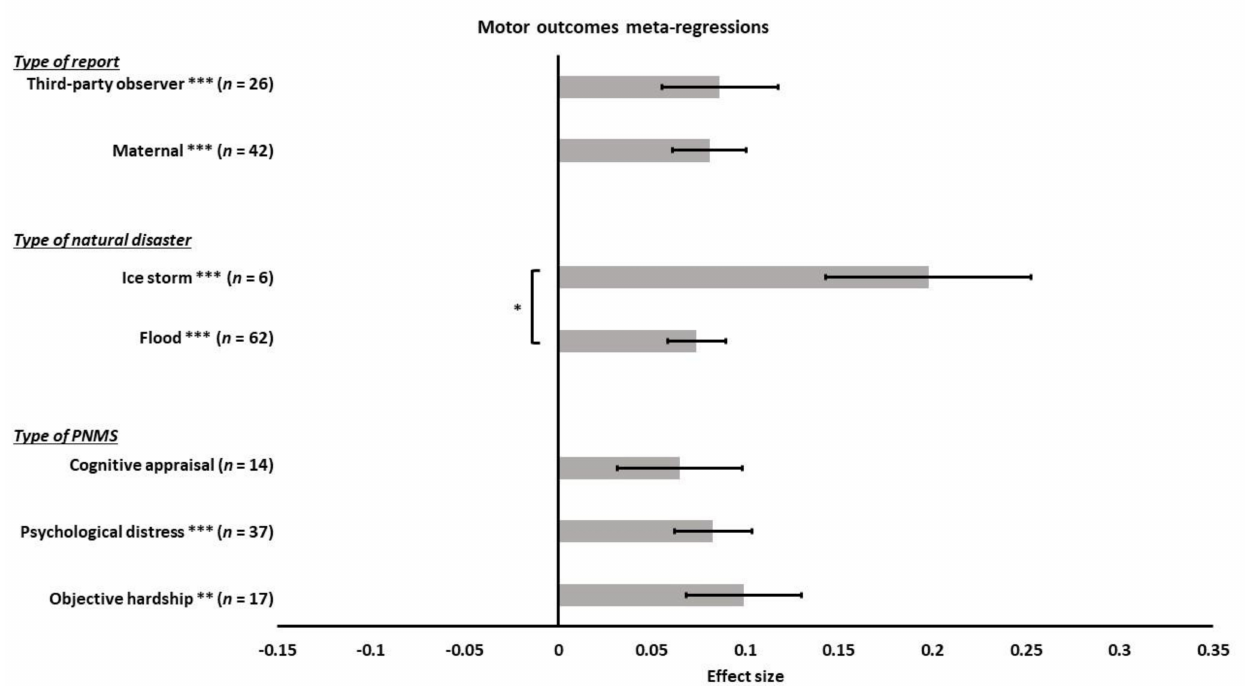
Figure 10. Motor outcomes meta-regressions. Type of PNMS effect (objective hardship; psychological distress; cognitive appraisal) on motor outcomes, type of natural disaster effect (flood; ice storm) and type of report (maternal; third-party observer) on the association between PNMS levels and motor outcomes. Note: * p < 0.05; ** p < 0.01; *** p <